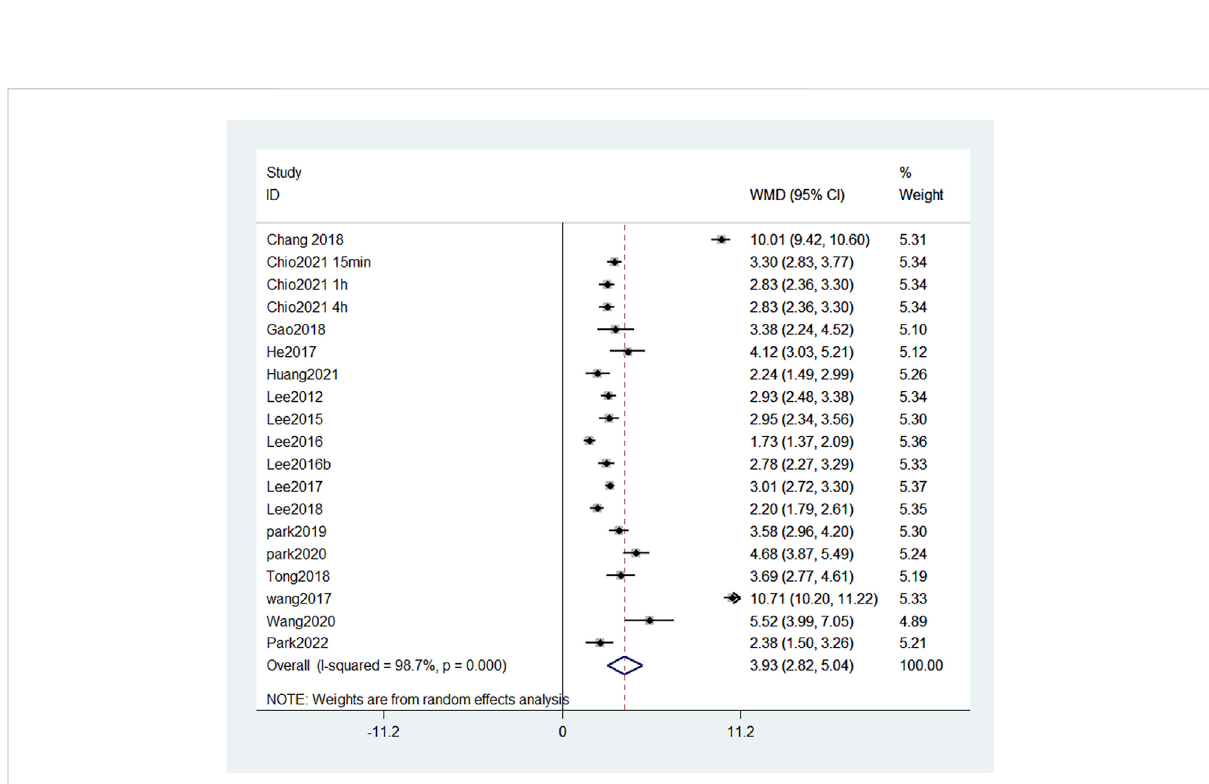
FIGURE 5 Forest plot of mean difference in BBB score after SCI and treatment at fourth